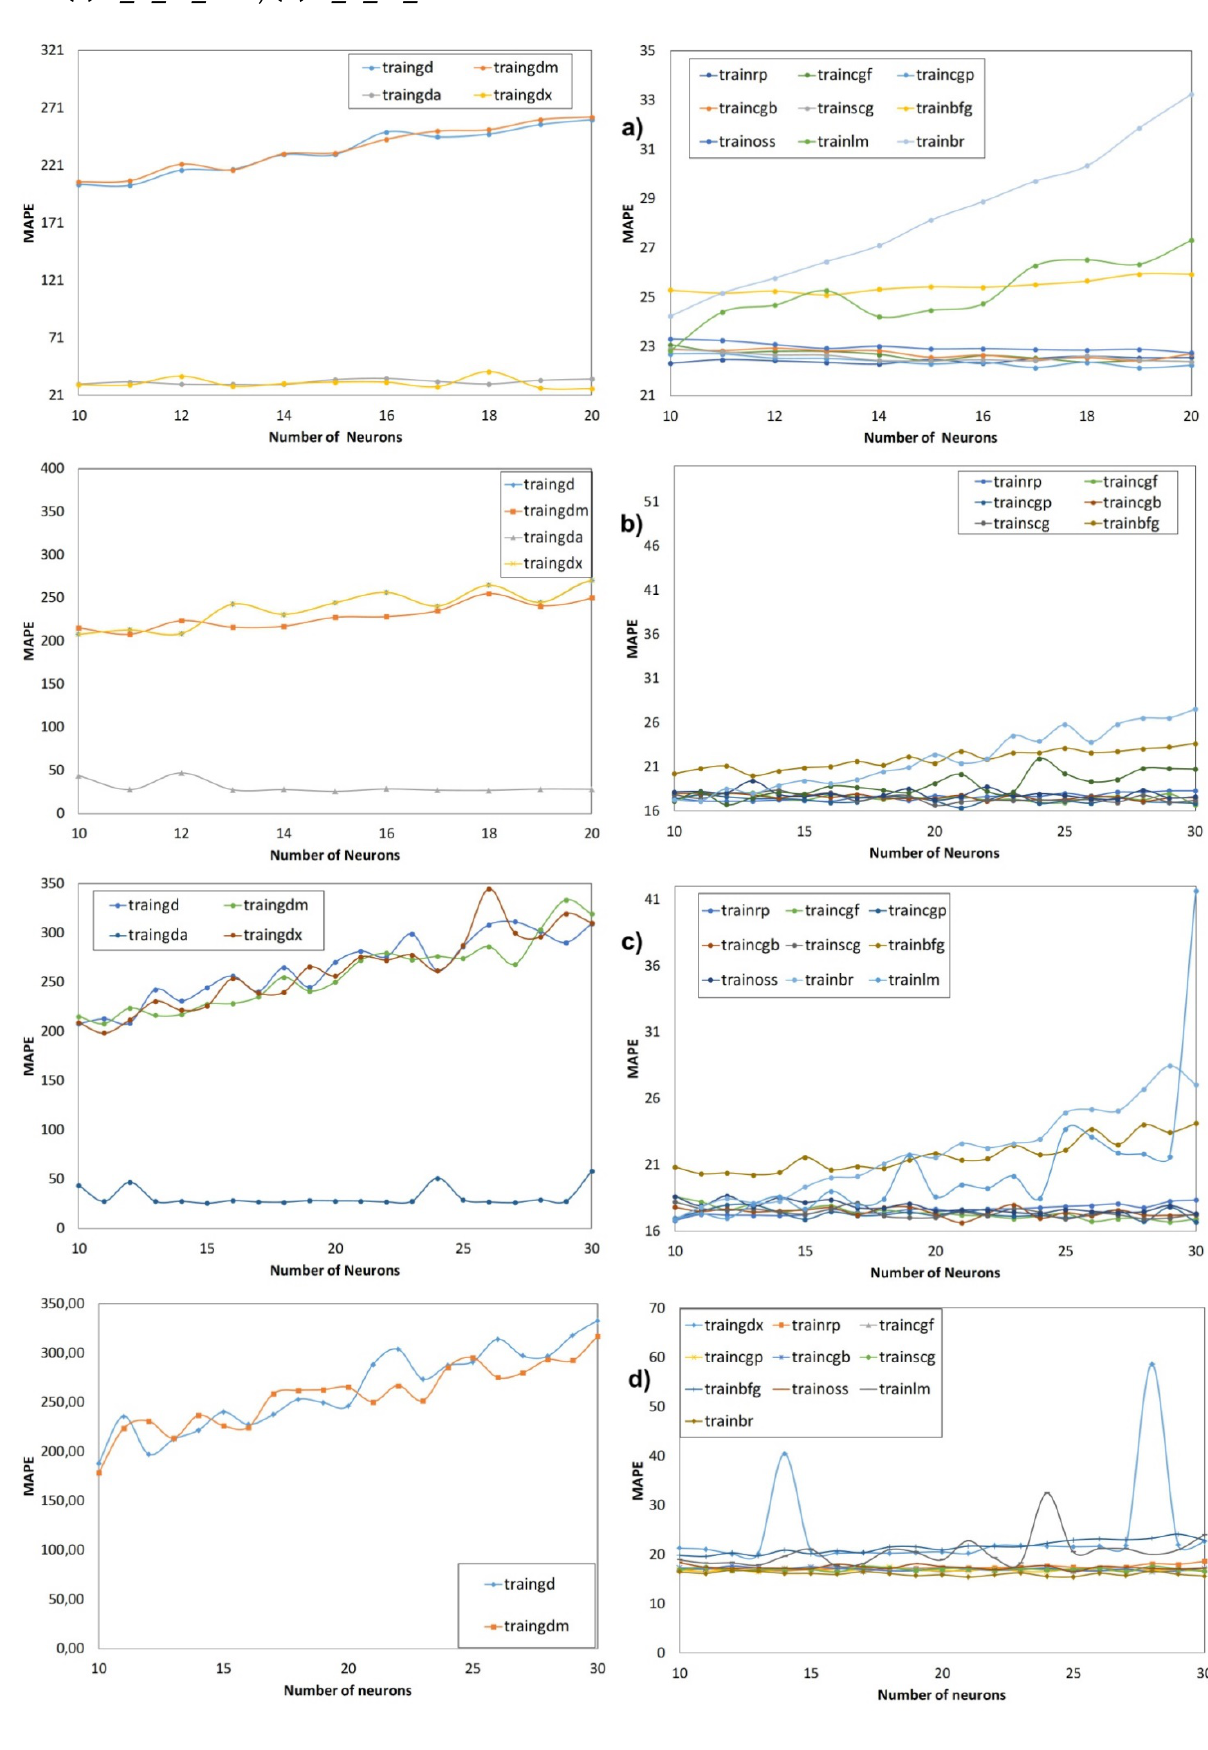
Figure 5. MAPE (%) (5) in each of the models for the Data Set A: ( a ) F_L ; ( b ) F_L_W